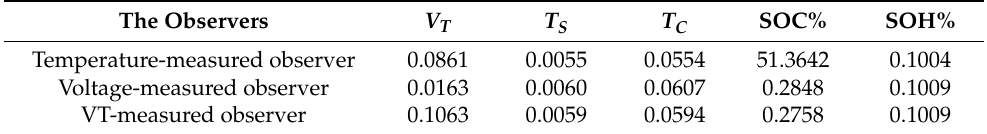
Table 5. RMSE of EKF using wrong initial